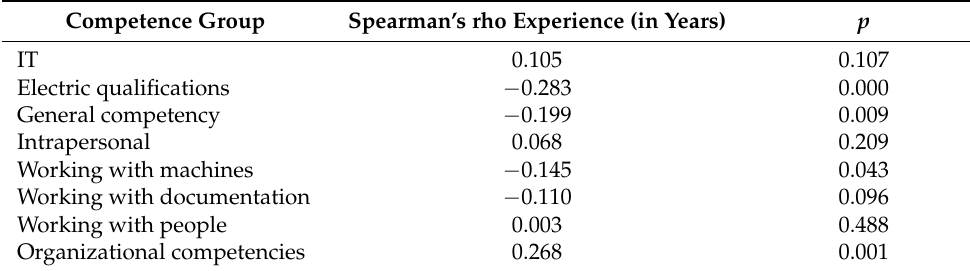
Table 15. Correlation between experience and the number of required competencies.